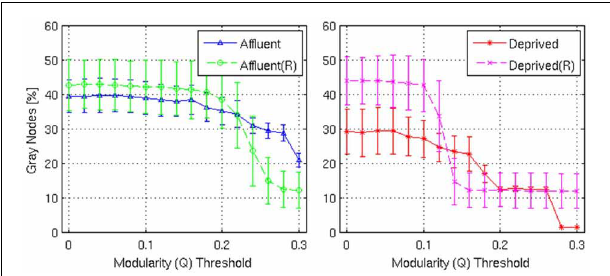
FIGURE 10 | Shows the proportion of gray nodes with respect to the corresponding Modularity threshold. Error bars represent the 1 σ -bound for each case. In the module calculation algorithm, if the module contribution, Q or (cid:2) Q , is less than the threshold, it was declared indivisible. Higher thresholds imply strong modules. Gray nodes have two implications in the network structure: (i) efficient usage of resources and (ii) shorter average distance between nodes. Recycling existing nodes and edges to combine multiple modules saves limited resources to construct the network. It is believed that reducing wiring resources is one of the major selection pressure on the brain network evolution. Affluent: Least deprived; Deprived: Most